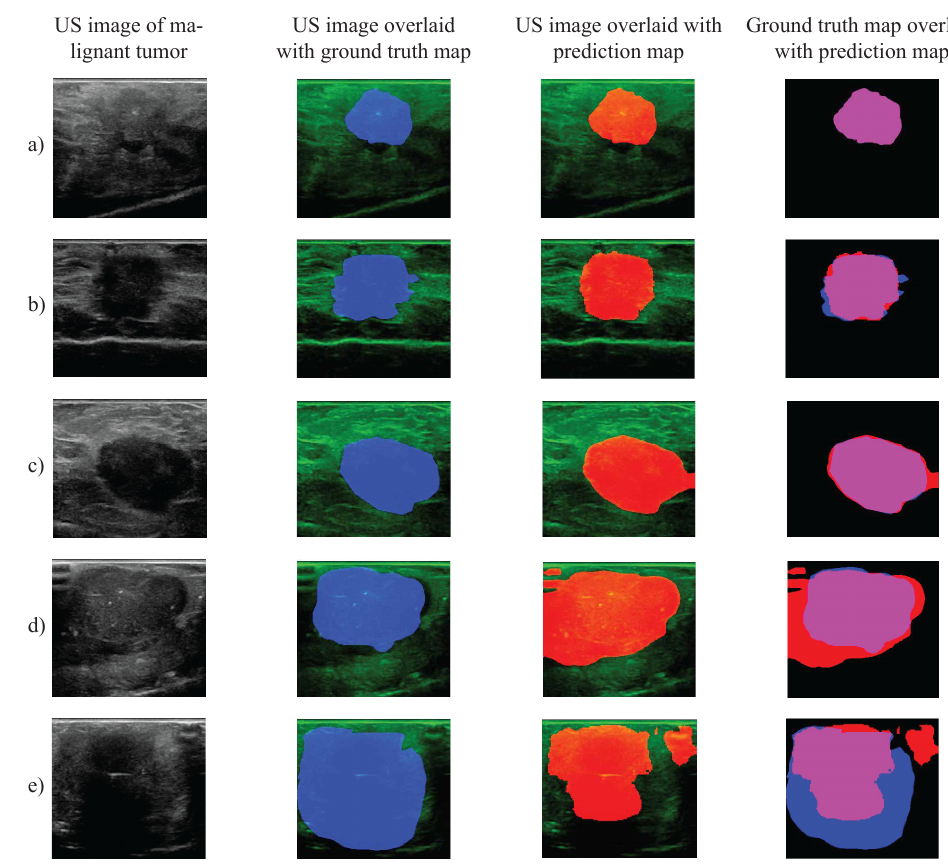
Figure 8. 5 examples of BCS-US segmentation of different invasive carcinoma lesions. ( a – c ) images of lesions with high DSC scores and accurate segmentation results, ( d ) an example of an artifact due to the absence of contact between the US probe and the tissue surface on the left side of the image, ( e ) example of a hydromarker on the right side of the image and an artifact due to acoustic shadowing beneath the tumor lesion. Blue shade: ground truth based human expert annotations; Red shade: automatic tumor segmentation using the optimized weighted average ensemble learning method; Purple shade: the agreement between the human observer and automatic